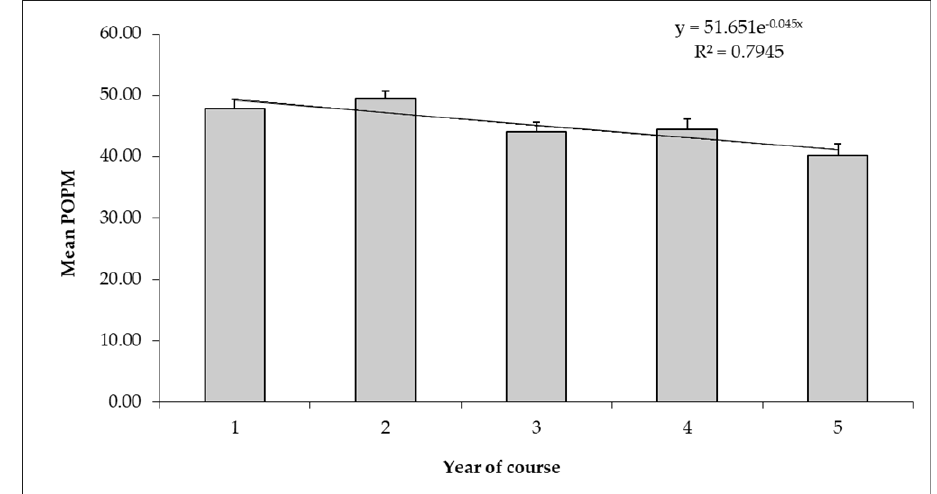
Figure 4. Students’ scoring tendency on animal Research subscale by year of course. Data were represented determining an exponential regression model equation. POMP: Percentage of maximum possible score.